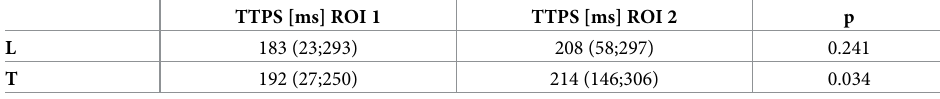
Table 3. Radial and longitudinal time to peak strain of regions of interest both ROI reflecting the atria.